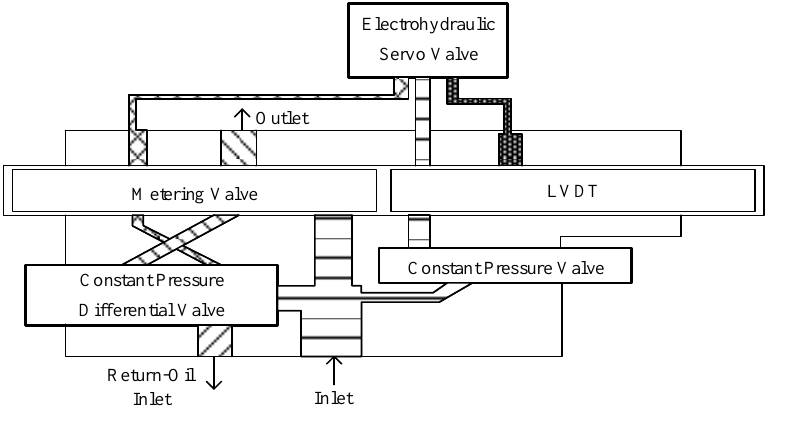
Figure 9. Speed closed-loop control model in Simulink.